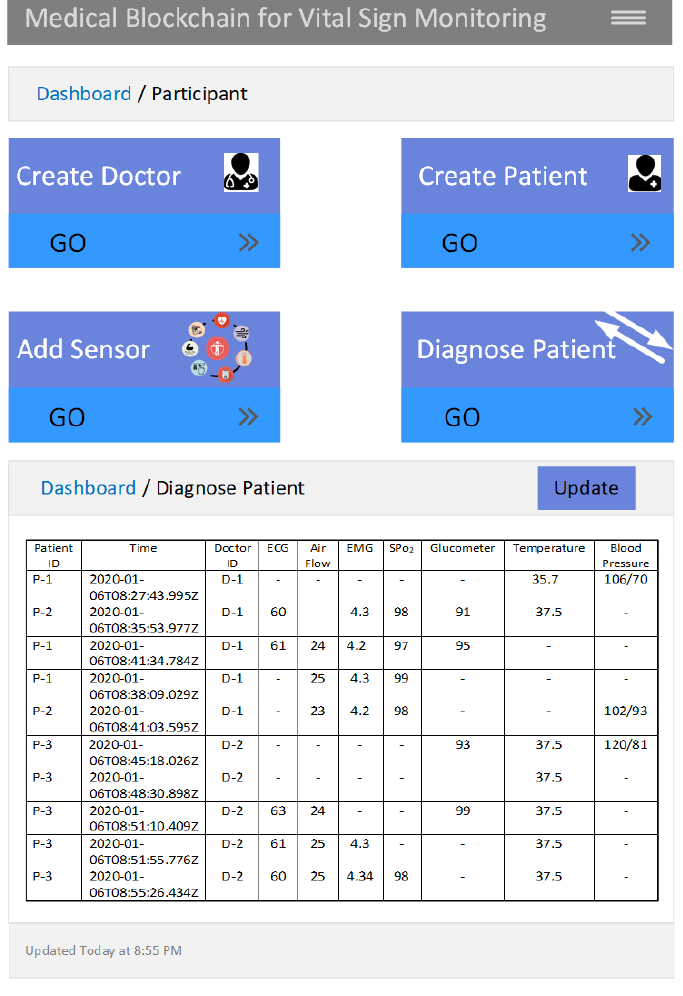
Figure 9. Web-based user interface for vital-sign monitoring with Hyperledger